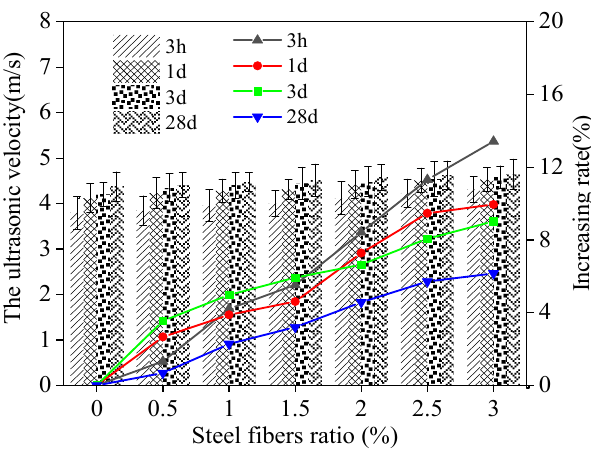
Figure 8. Ultrasonic velocity of MPC-RPC.